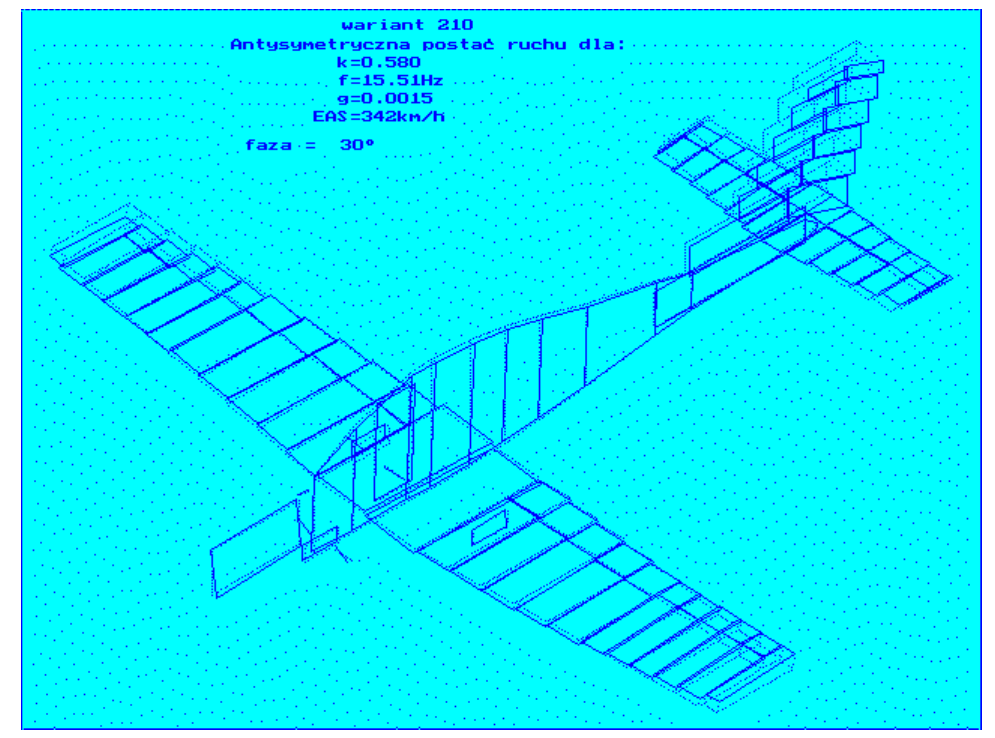
Fig 3. The V flutter mode before improvement of rudder mass